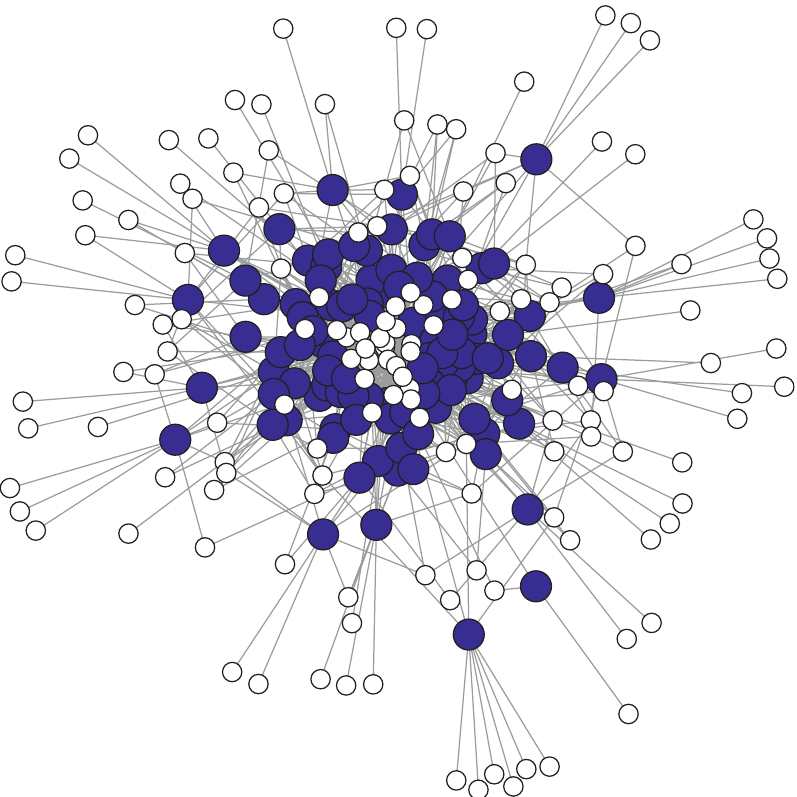
Figure 1: The bipartite network on 31 March